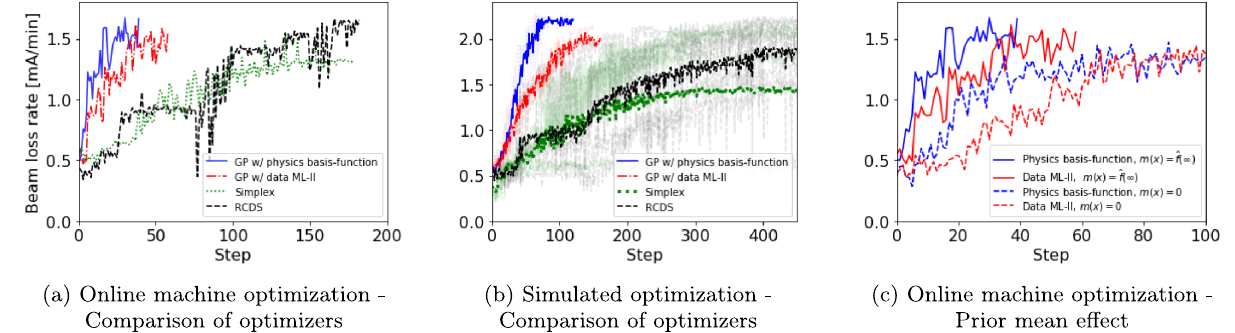
FIG. 2. (a) Comparison of optimization of beam loss rate over 13 skew quadrupole magnets for Gaussian process (GP) with physics- informed kernel including off-diagonal elements (blue), GP with diagonal-only data-informed kernel (red), Nelder-Mead simplex (green), and RCDS (black). Each step corresponds to approximately 1 to 2 seconds for GP and simplex, and to 6 seconds for RCDS. (b) Simulations using the conditions of (a). Six individual scans for each method, with means shown by thick lines, are consistent with the relative performance of the online optimizations. (c) Comparison of GP optimizers with the objective ’ s offset as prior mean (solid), and without